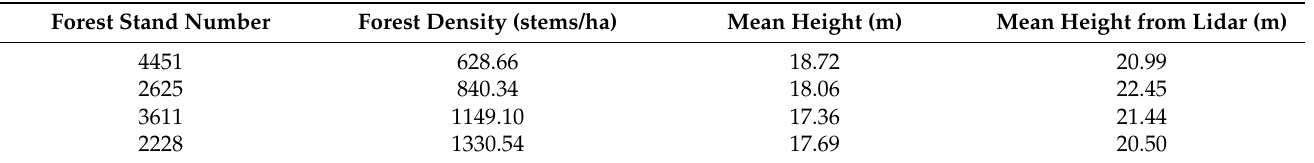
Table 4. The forest density and height of four realistic scenario forest stands. The mean height was measured manually in the field, and the mean height from Lidar is